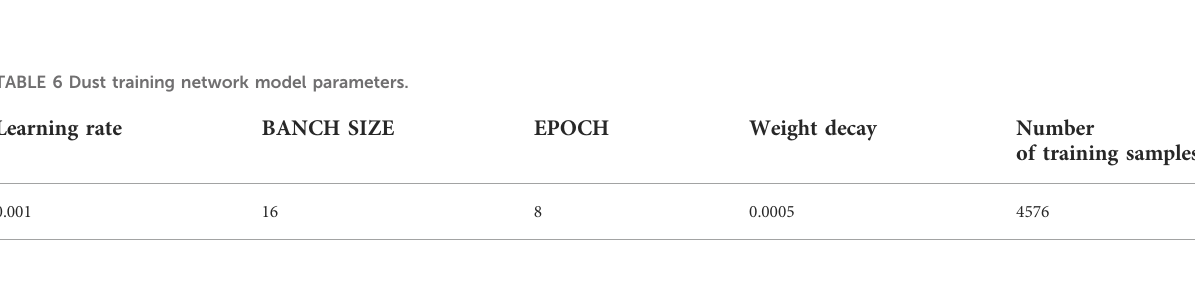
TABLE 7 Evaluation index of the sandstorm detection